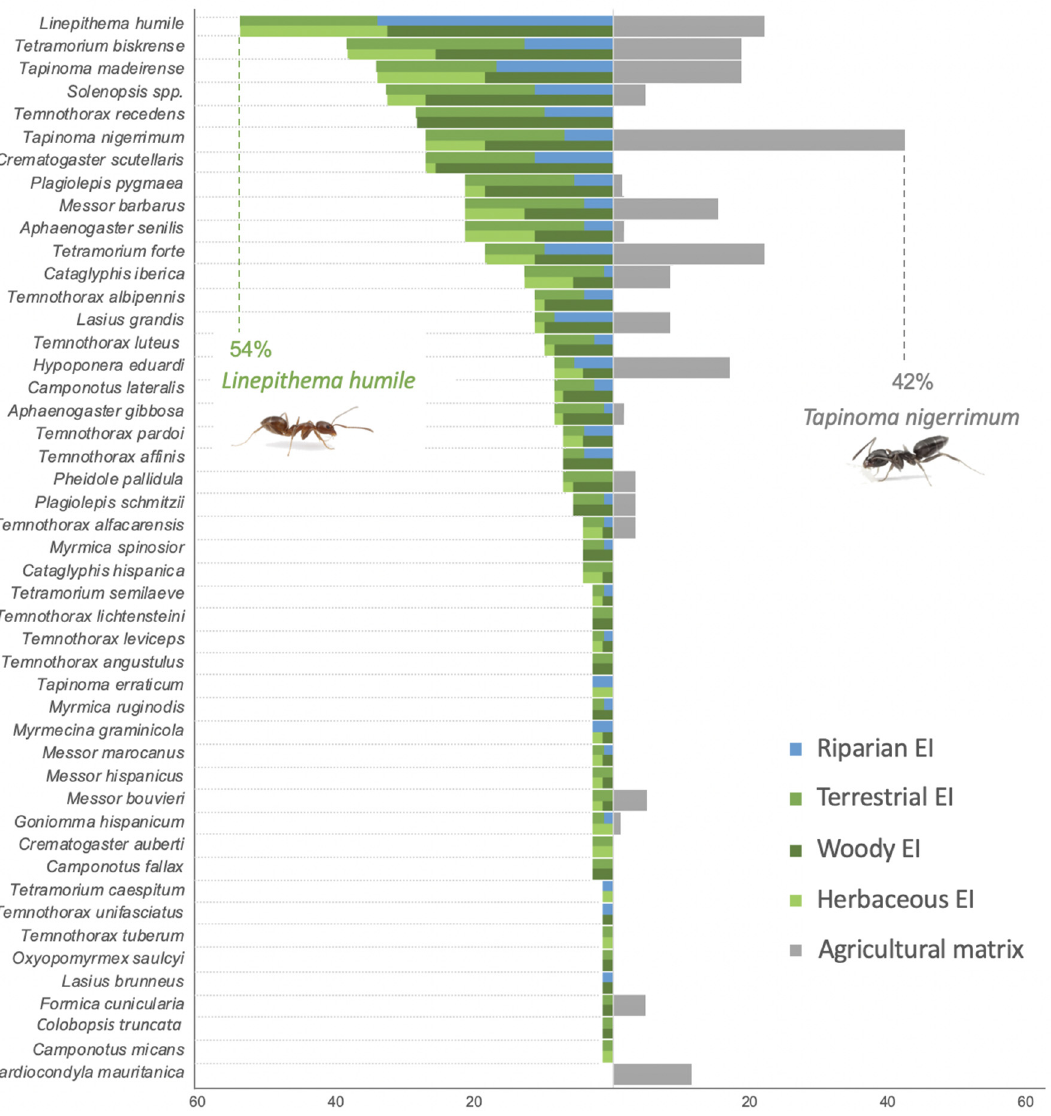
Figure 4. Frequency distribution of ant species occurrence (in percentage) as a function of the sites sampled in the ecological infrastructures (EI) (left blue-green bars) and the agricultural matrix (right gray bars).